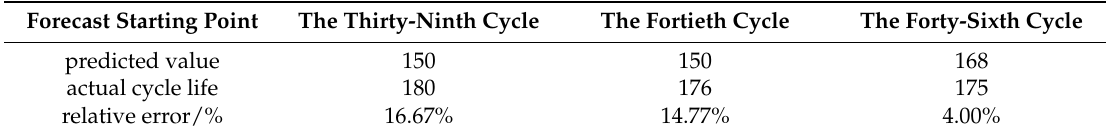
Figure 4. Fitting linear attenuation curves before and after the change point. Table 5. Comparison of the prediction results before and after the battery change point.